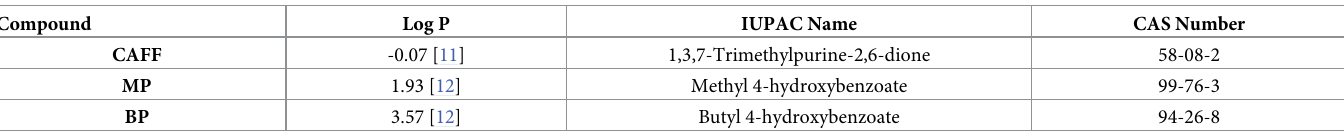
Table 1. Structure and log P values of the proposed